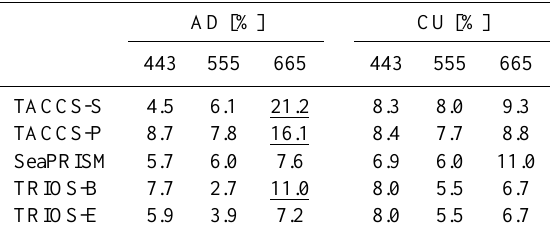
Table 13. Average values of the absolute of relative percent dif- ferences (AD) determined for R rs (λ) at the 443, 555 and 665nm center-wavelengths for the various systems/methods with respect to WiSPER, and combined uncertainties (CU) determined from the statistical composition of uncertainties quantified for R rs (λ) derived from WiSPER and from each other inter-compared system/method. Underlined values indicate AD significantly greater than the com- puted CU